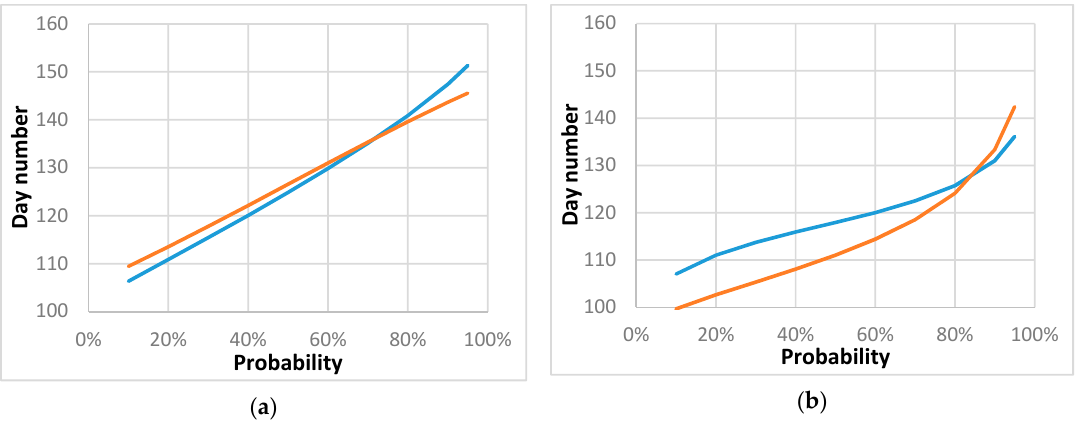
Figure 4. The probability curves of the last spring frost event described by a calendar day number (Tmin < 0 °C) in the period of 1961–1990 (blue line) and 1991–2020 (orange line). ( a ) Kielce ( b ) Poznan.